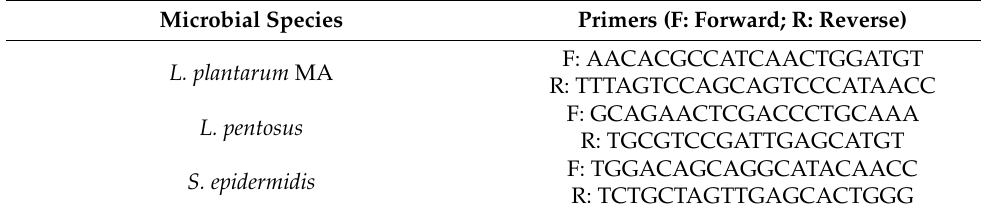
Table 1. Primers of the NDH-2 transcripts for three microbial sets. Microbial